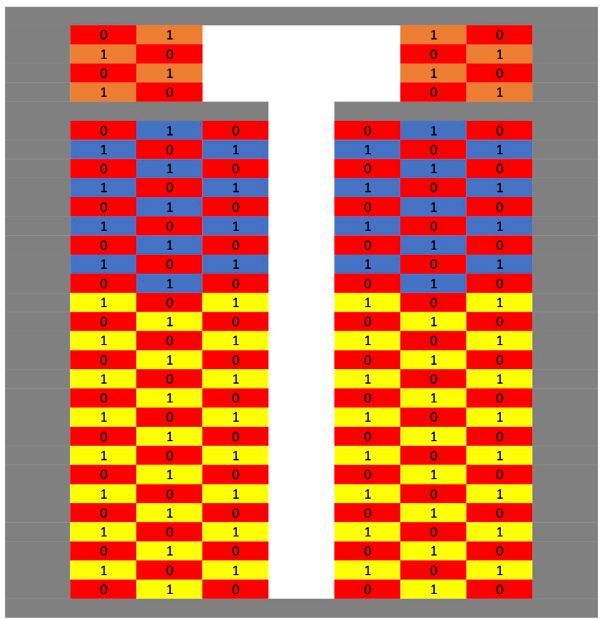
Fig 1. An example seating arrangement of a Boeing 737 at 50% capacity. Red cells (that are also labeled with 0s) are empty seats. Orange cells represent business class, blue cells represent premium economy, and yellow economy class. Cells with 1s are